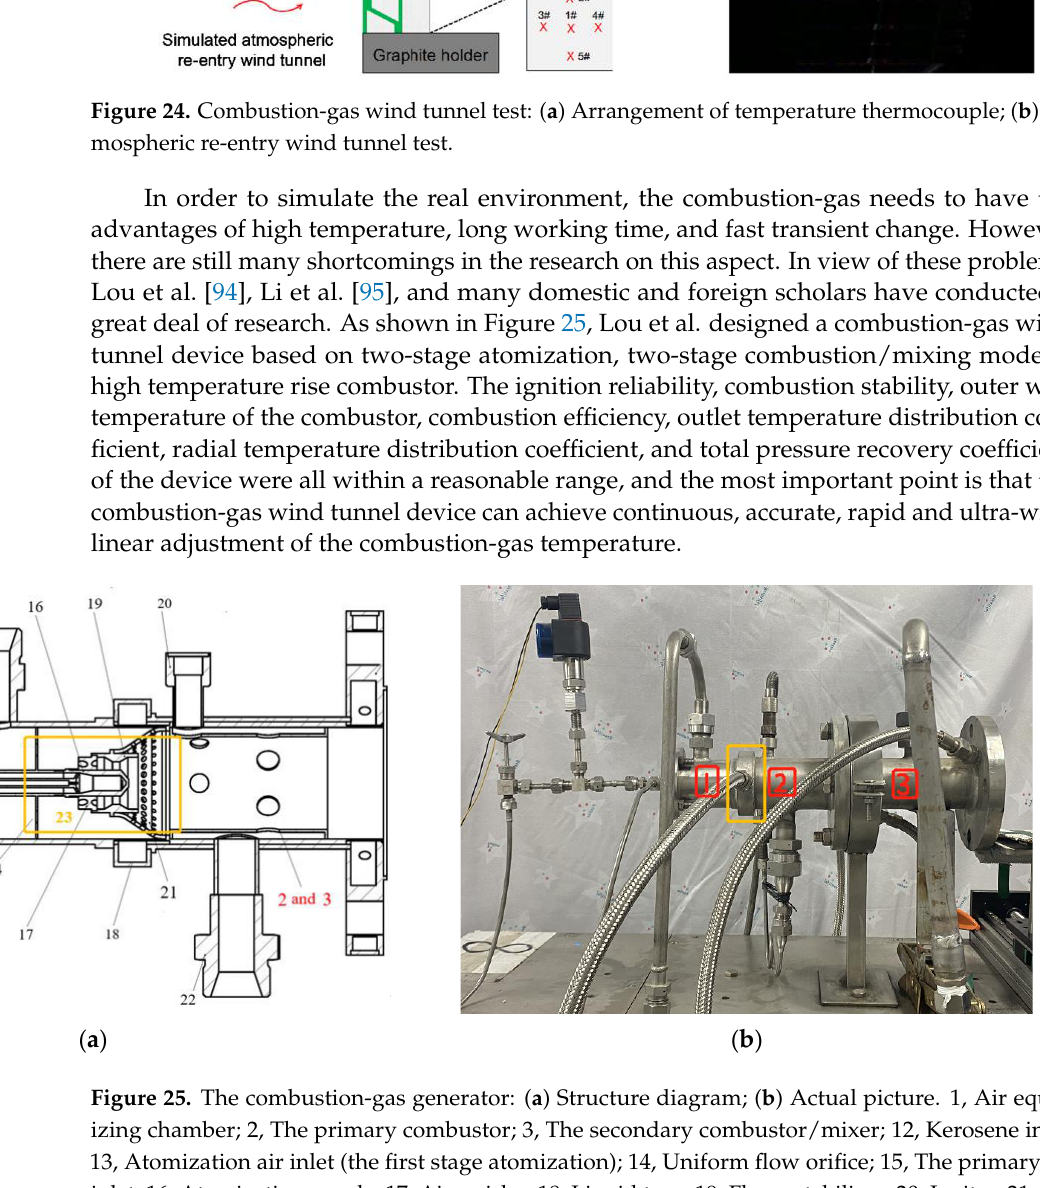
Figure 24. Combustion-gas wind tunnel test : ( a ) Arrangement of temperature thermocouple; ( b ) Atmospheric re-entry wind tunnel test. mospheric re-entry wind tunnel test.